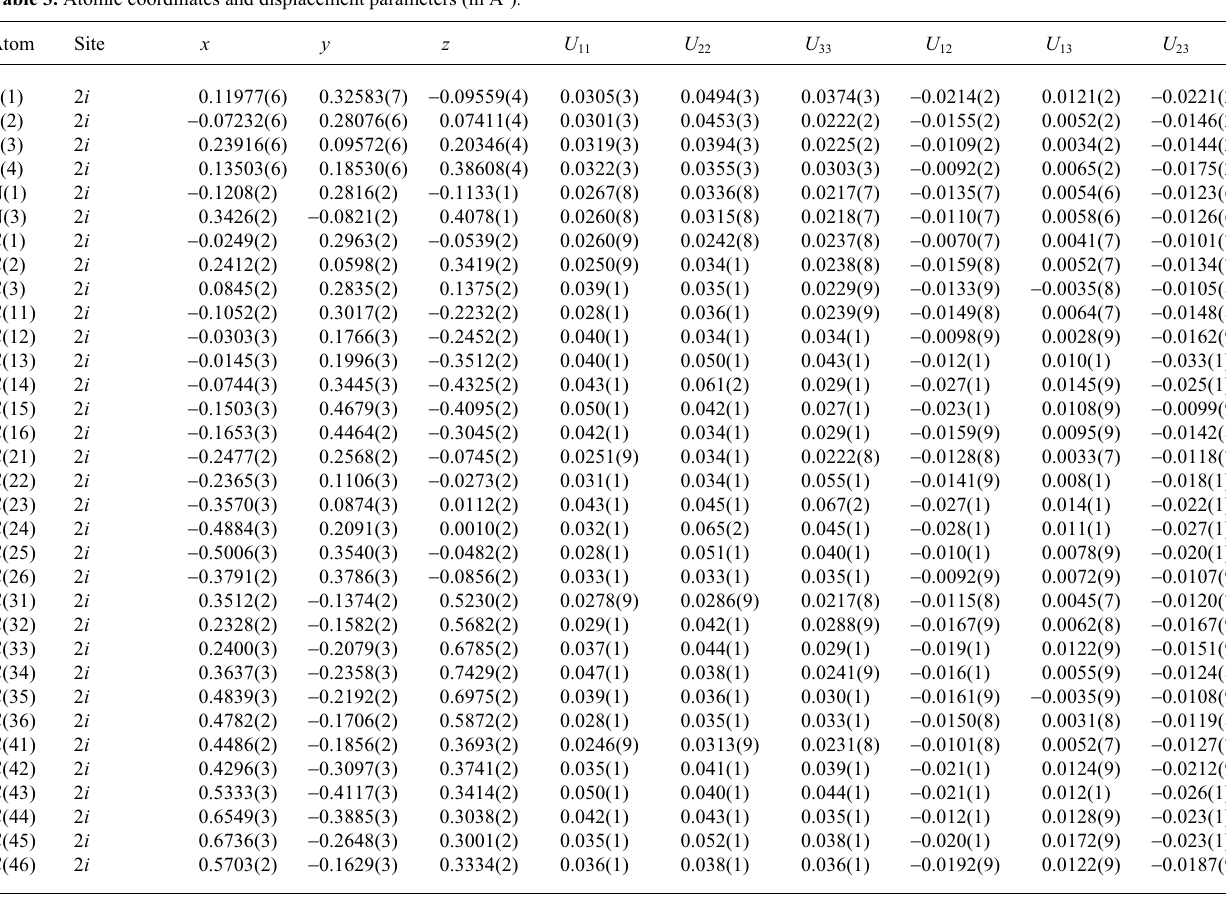
Table 3. Atomic coordinates and displacement parameters (in Å 2 )